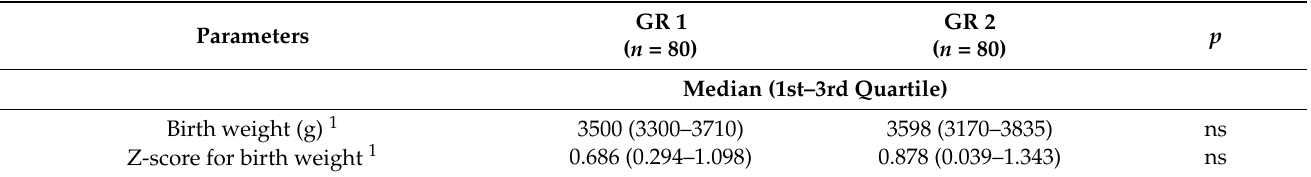
Table 2. Body weight in